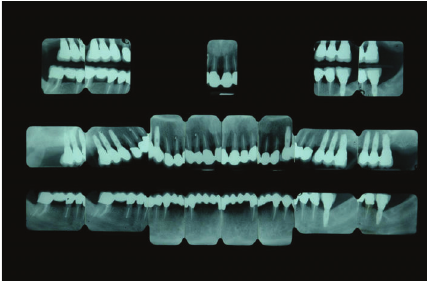
Figure 41: Final case: full-mouth intraoral radiographic exam (May